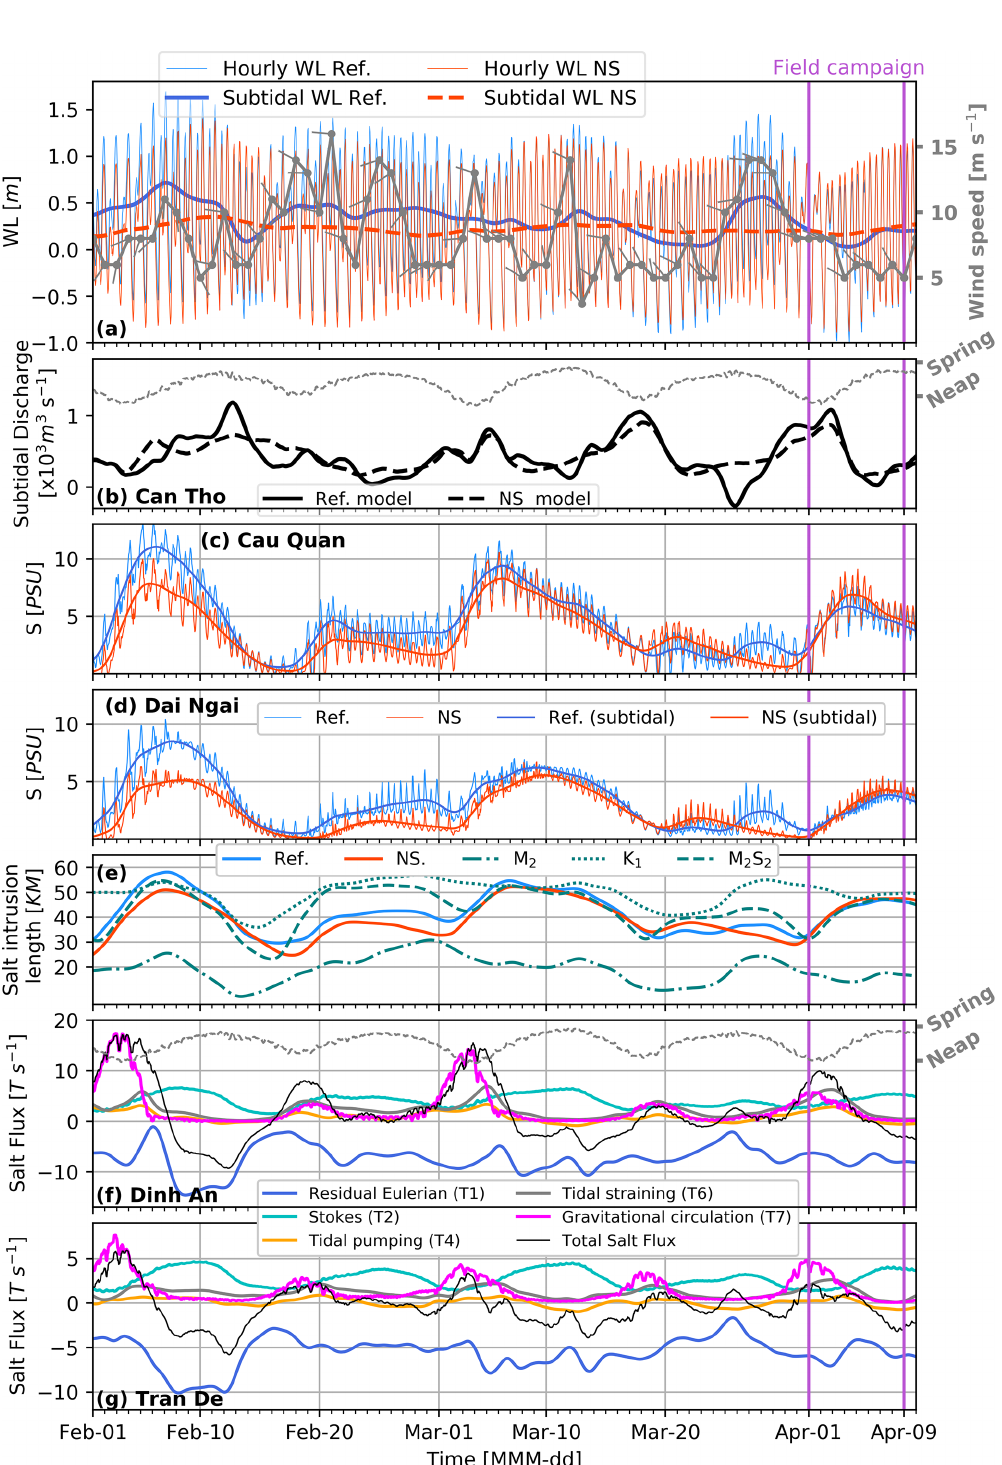
Figure 7. Comparison of the reference model (Ref.) including the ocean surge and the No-Surge (NS) model excluding the ocean surge for (a) water level (b) discharge. Panels (c) and (d) show salinity in the Dinh An and Tran De channels, respectively. (e) Salt intrusion length in time along the Dinh An distributary of the Hau River in the reference (Ref.) model in comparison to the NS (No-Surge), M 2 (only including the M2 tidal constituent), and M 2 S 2 (replicating a spring–neap cycle) models. Panels (f) and (g) show various salt fluxes (positive upstream) in Dinh An and Tran De, respectively, at cross sections 15km from the estuary mouth in the reference simulation.